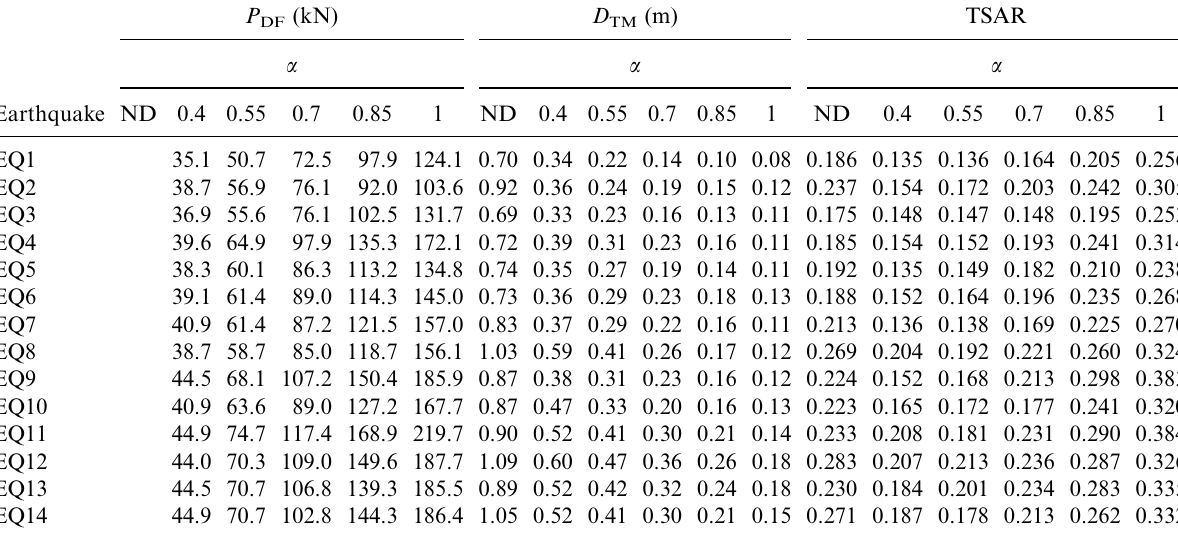
Table 5. Response parameters when C (cid:3) 350 kN-s/m P DF (kN) D TM (m) a